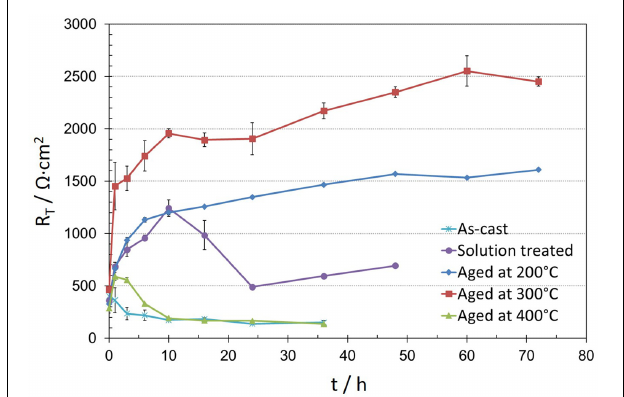
FIGURE 8 | Average evolution of total resistance (RT) values obtained after fitting EIS spectra of as-cast, solution treated and heat treatments at 200 ◦ C,